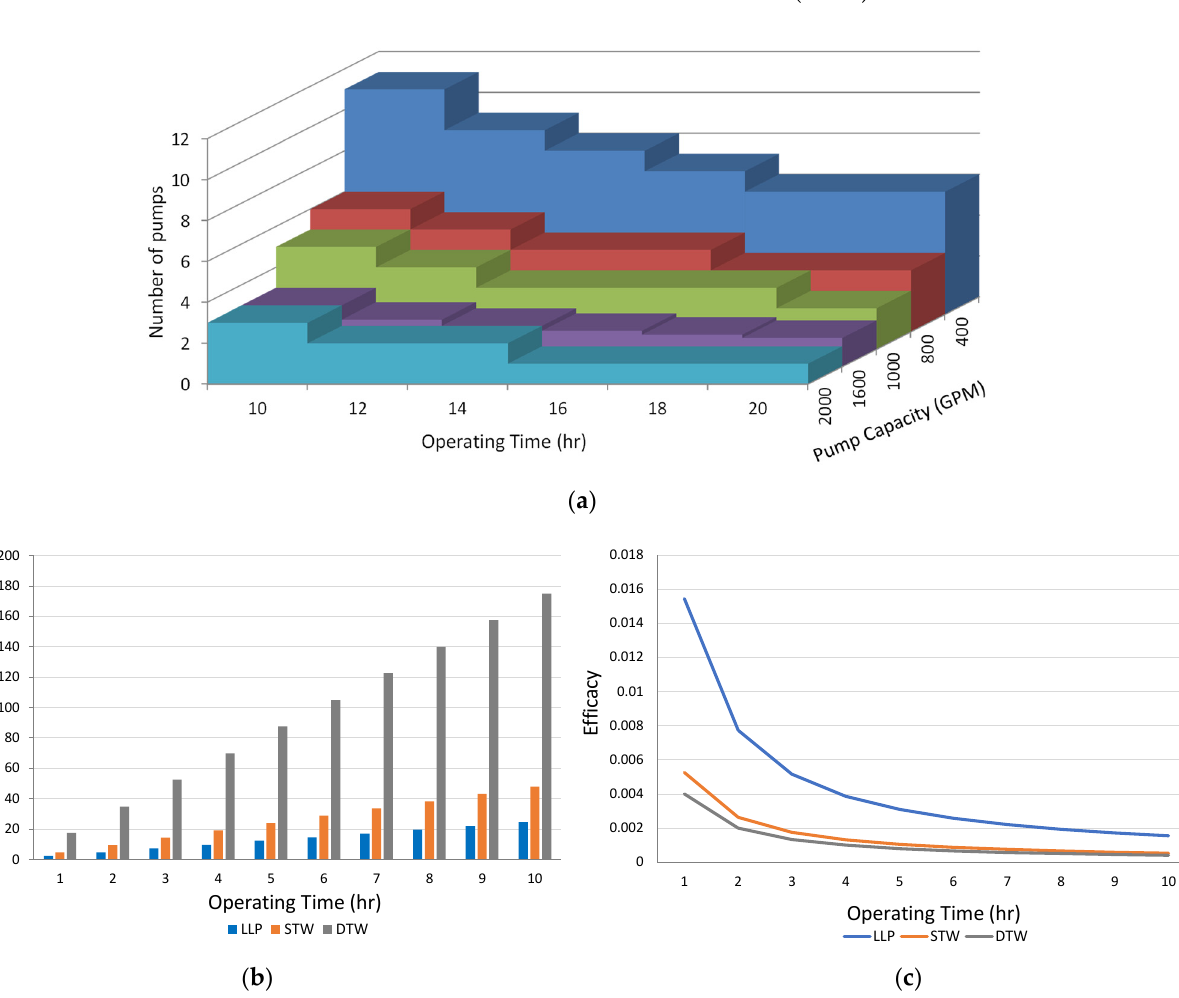
Figure 5. ( a ) Number of pumps required when operating for duration of time ( b ) Average power consumption between different water lifting devices ( c ) Efficacy of the water lifting devices.